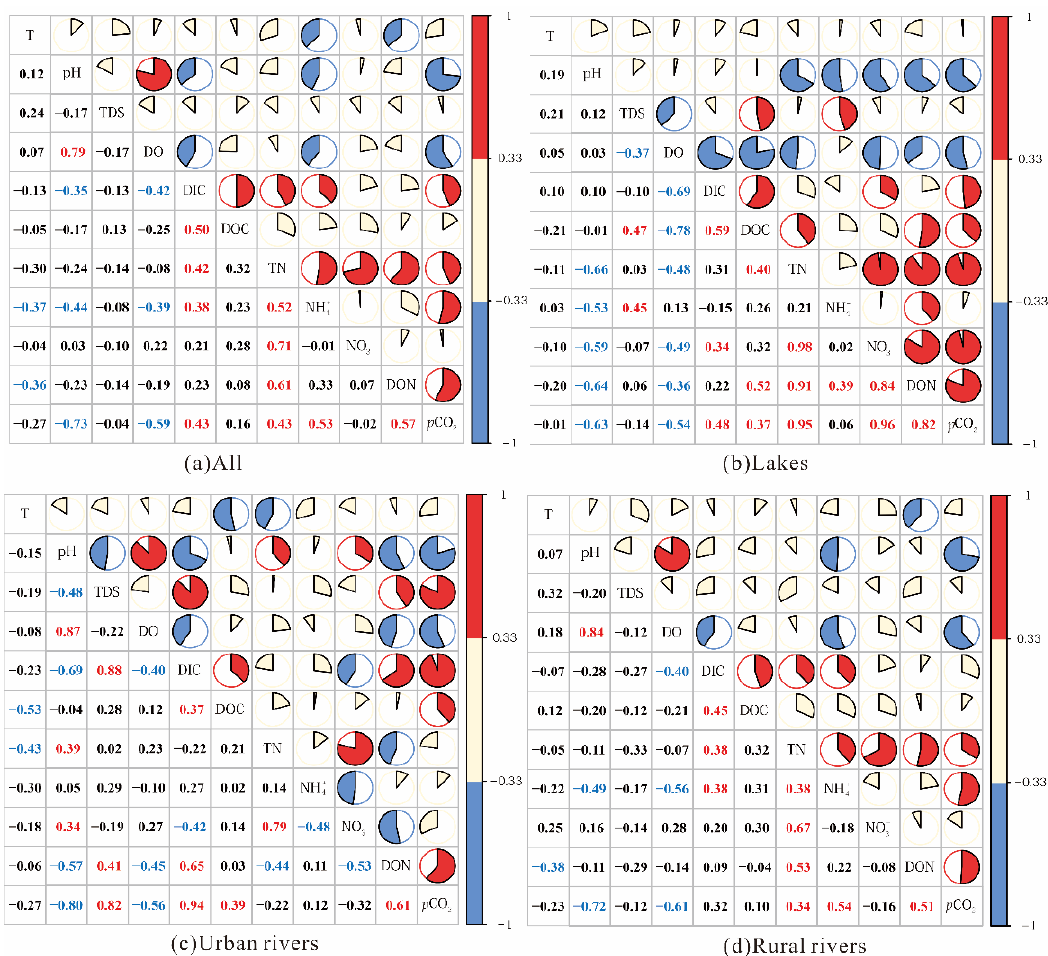
Figure 4. Correlations of water environmental parameters in surface water in Tianjin, China. The colors represent the range of correlation coefficient. Red indicates positive correlations (ranging from 0.33 to 1), blue indicates negative correlations (ranging from −1 to −0.33), and light yellow indicates weak correlations (ranging from −0.33 to 0.33). The ratios of colored areas in circles represent the degree of correlations.